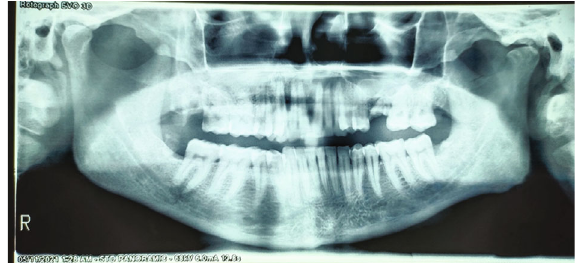
Figure 6: OPG of case